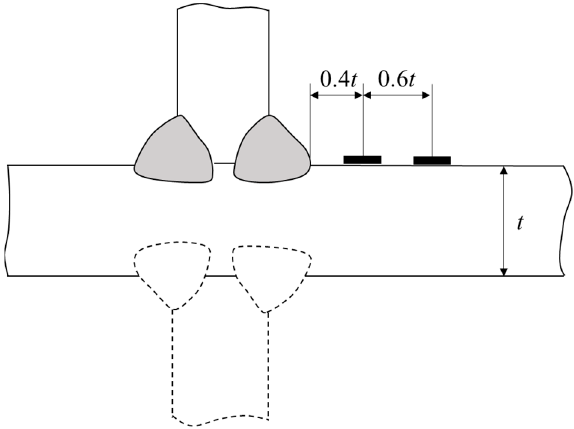
Figure 8. Position of strain gauges.